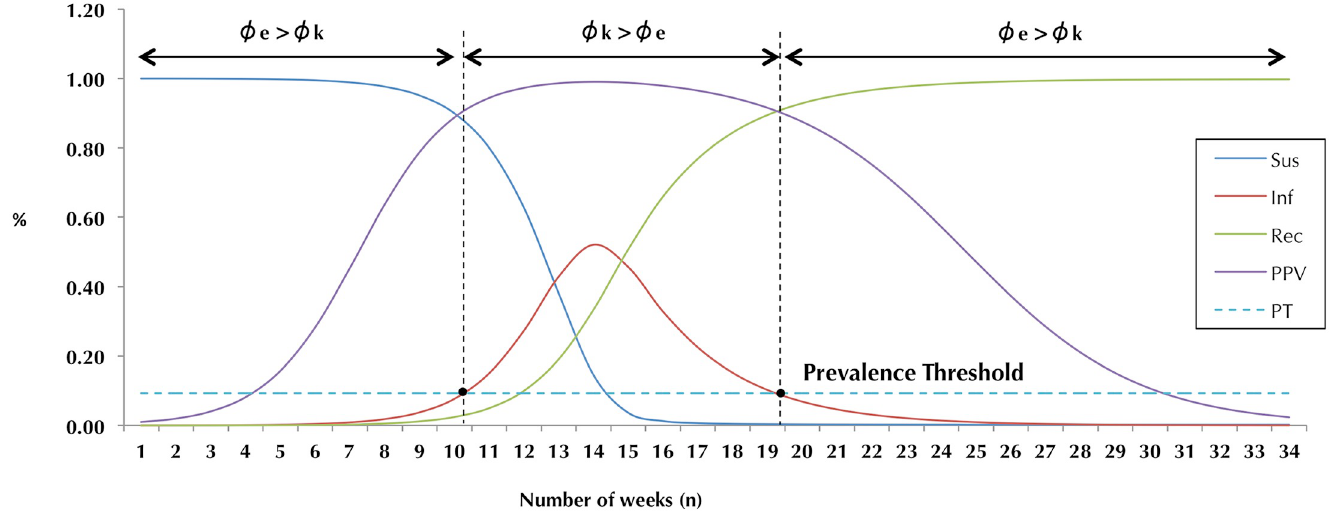
Fig 4. SIR + PPV: The SIR-P